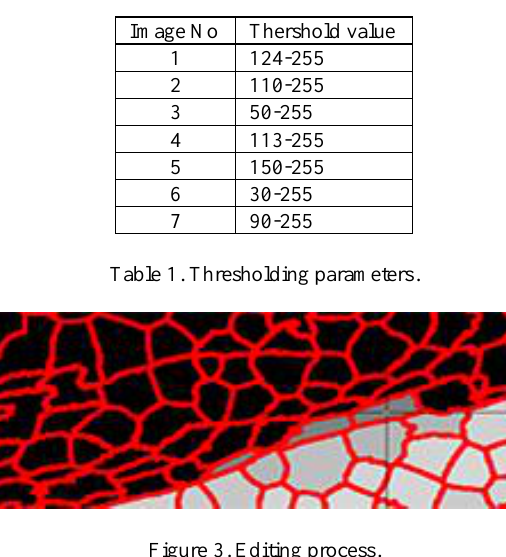
Figure 3. Editing process.